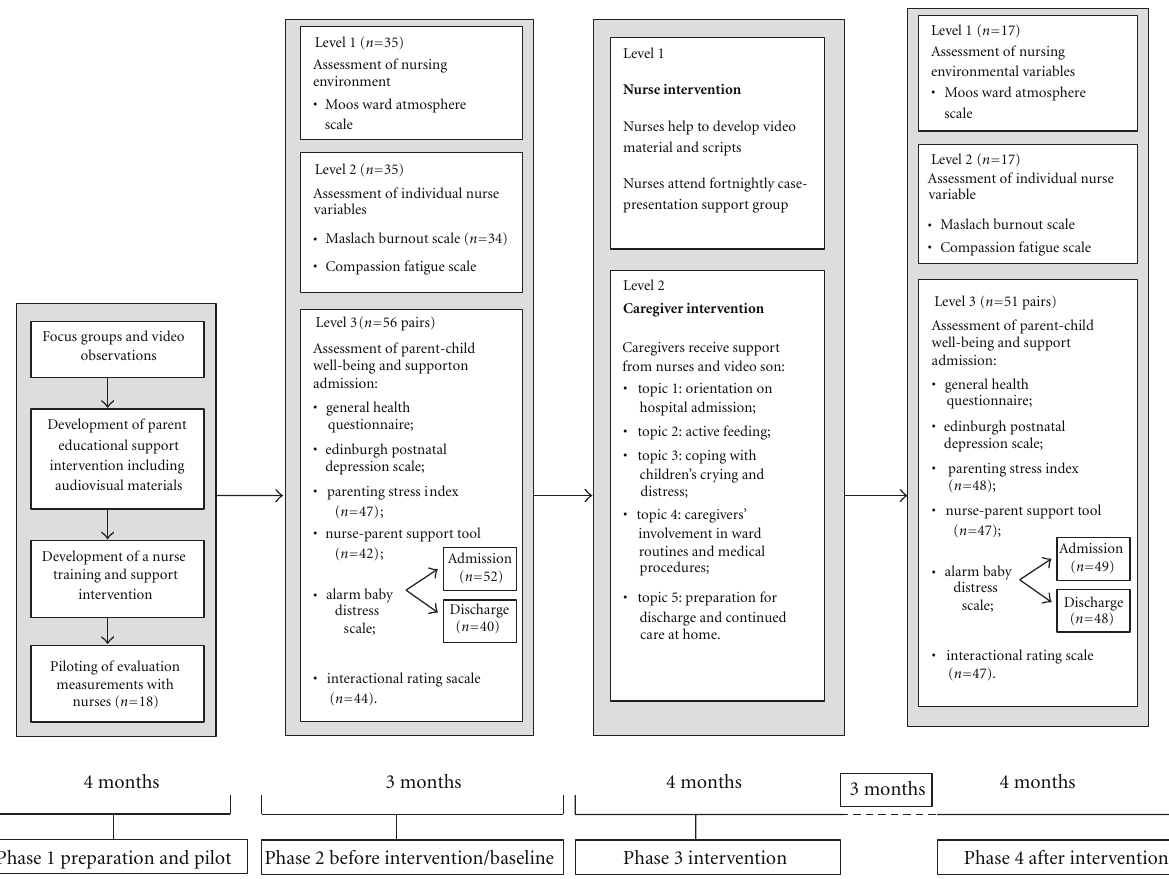
Figure 1: Overview of intervention